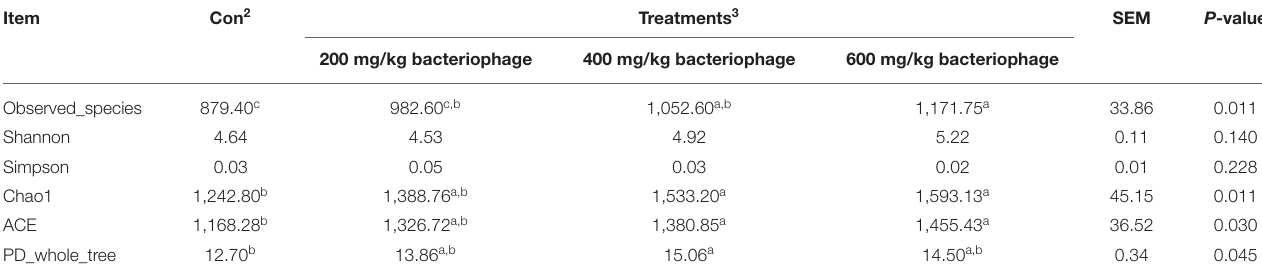
TABLE 7 | Effect of dietary bacteriophage supplementation on the alpha diversity of caecum microbiota in weaned piglets fed antibiotic-free diet ( n = 5) 1 . Item